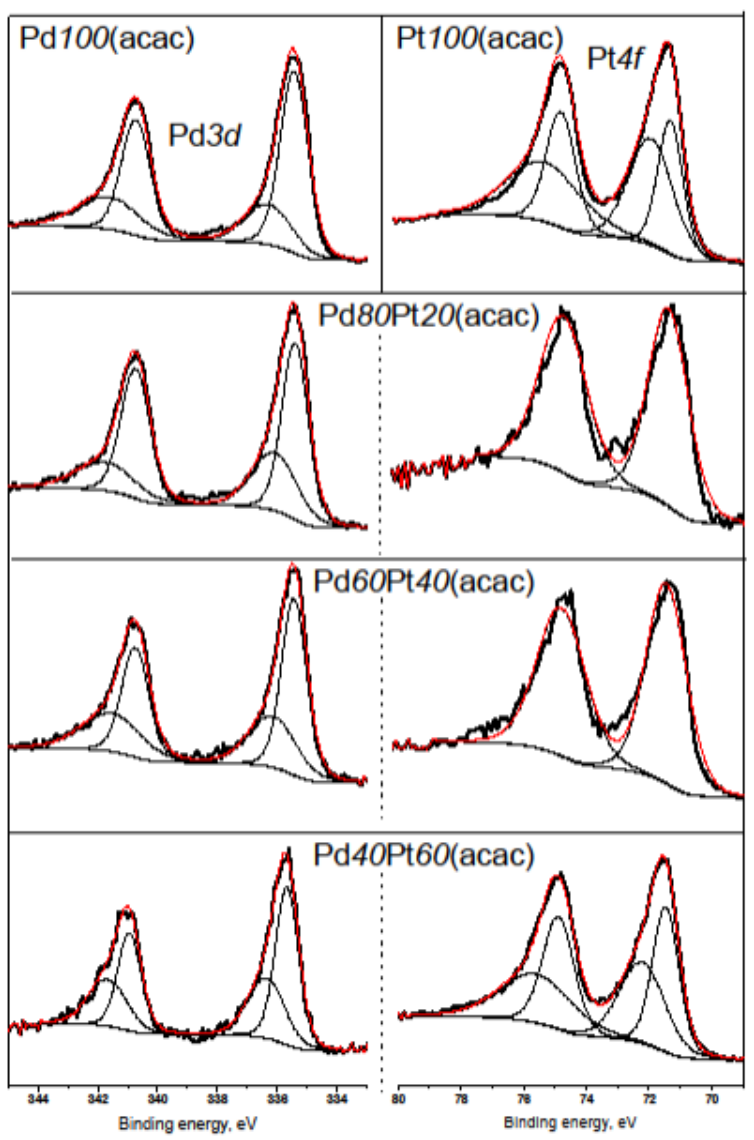
Figure 6. XPS profiles in the Pt 4f region (right) and the Pd 3d region (left) of the Pd–Pt(ex-acac) catalysts. Thin black lines—deconvoluted spectra, red lines—fitted overall profiles, thick black lines—envelope spectra.